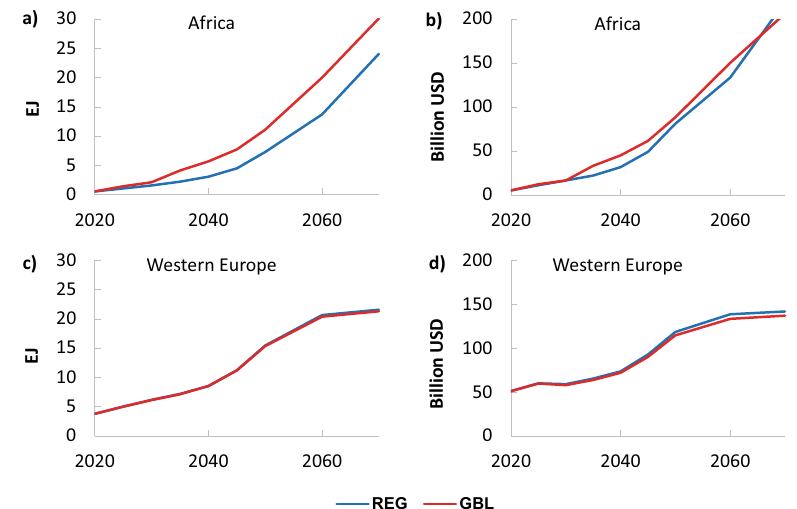
Fig. 3 Low-carbon electricity generation and related investment per year. The left-hand panels show low-carbon electricity generation in EJ for ( a ) Africa and ( c ) Western Europe, while the right-hand panels show related investment per year in Billions of USD in ( b ) Africa and ( d ) Western Europe.